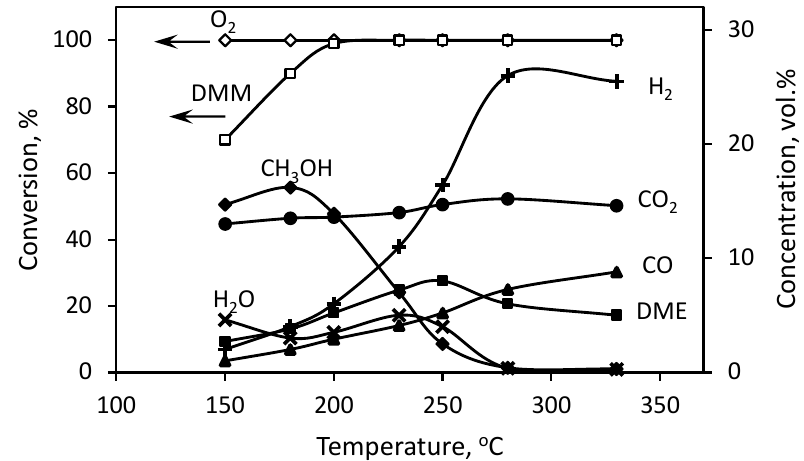
Figure 1. E ff ect of reaction temperature on dimethoxymethane (DMM) conversion and outlet concentrations in DMM partial oxidation (PO) over CuO-CeO 2 / γ -Al 2 O 3 catalyst. Reaction conditions: Figure 1. Effect of reaction temperature on dimethoxymethane (DMM) conversion and outlet P = 1 atm; GHSV (gas hourly space velocity) = 10,000 h − 1 ; Inlet composition: CH 3 OCH 2 OCH 3 :O 2 :N 2 concentrations in DMM partial oxidation (PO) over CuO-CeO 2 /γ-Al 2 O 3 catalyst. Reaction conditions: = 16.7:16.7:66.6